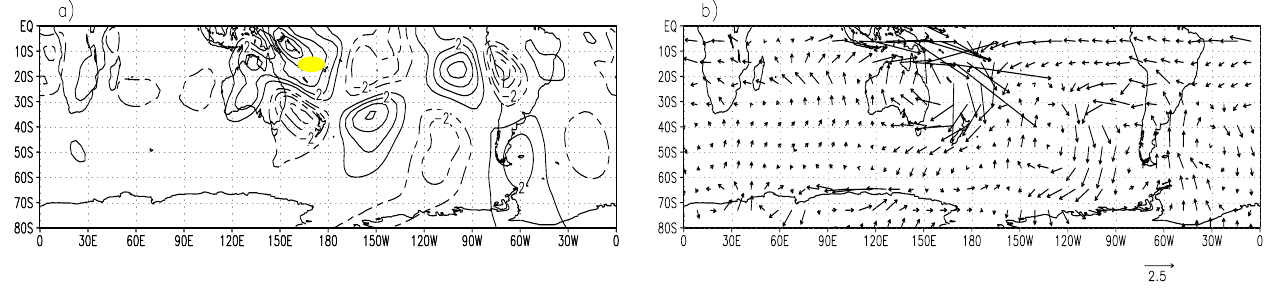
Figure 3 : Meridional wind component anomalies (ms -1 ) at 250 hPa (a) and wind vector anomaly at 850 Fig. 3. Meridional wind component anomalies (ms − 1 ) at 250hPa (a) and wind vector anomaly at 850hPa (b) , on day 10 of integration, hPa (b), on day 10 of integration, corresponding to the mean winter basic state experiment with the corresponding to the mean winter basic state experiment with the forcing at 170 ◦ E–15 ◦ S (see dot in the figure). forcing at 170ºE-15ºS (see gray dot in the figure)